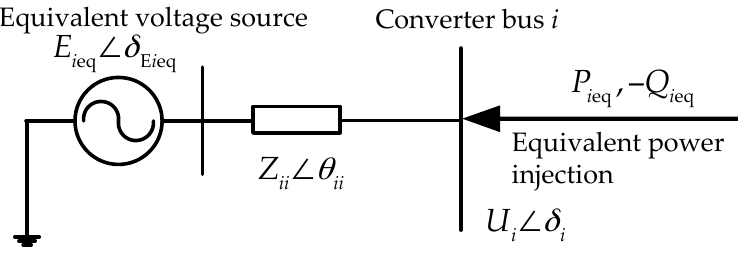
Figure 1. Two-bus equivalent model of the n -bus AC/DC power system.